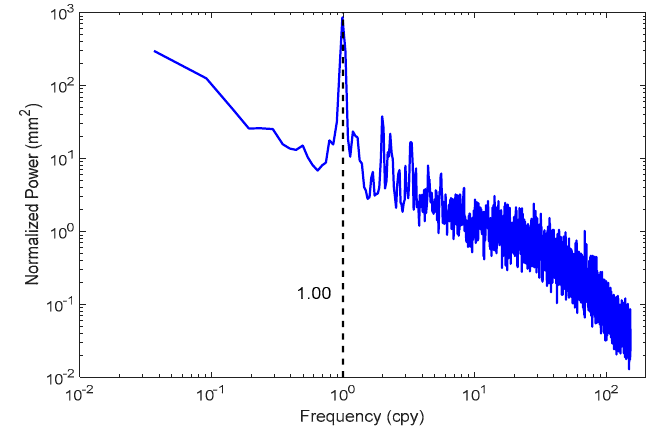
Figure 4. Stacked periodograms of displacement time series of all the grids.